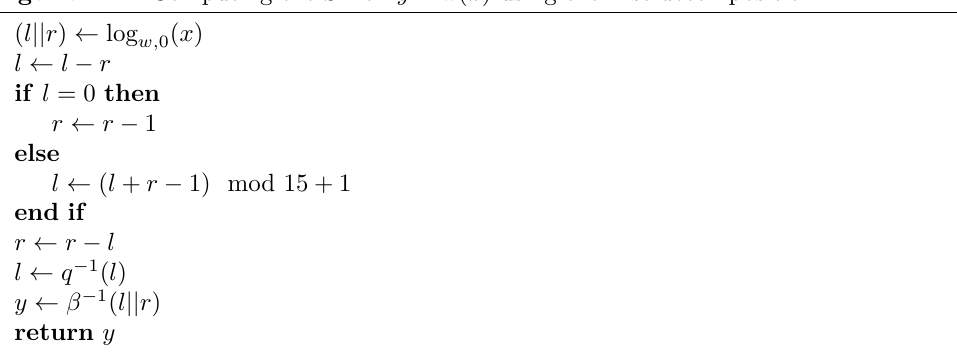
Algorithm 2 Computing the S-Box 𝑦 = 𝜋 ( 𝑥 ) using the first